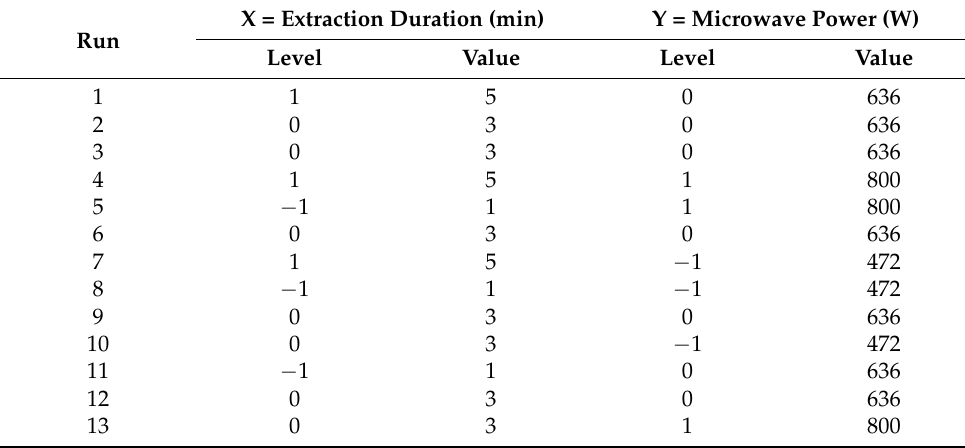
Table 2. Extraction conditions during optimization